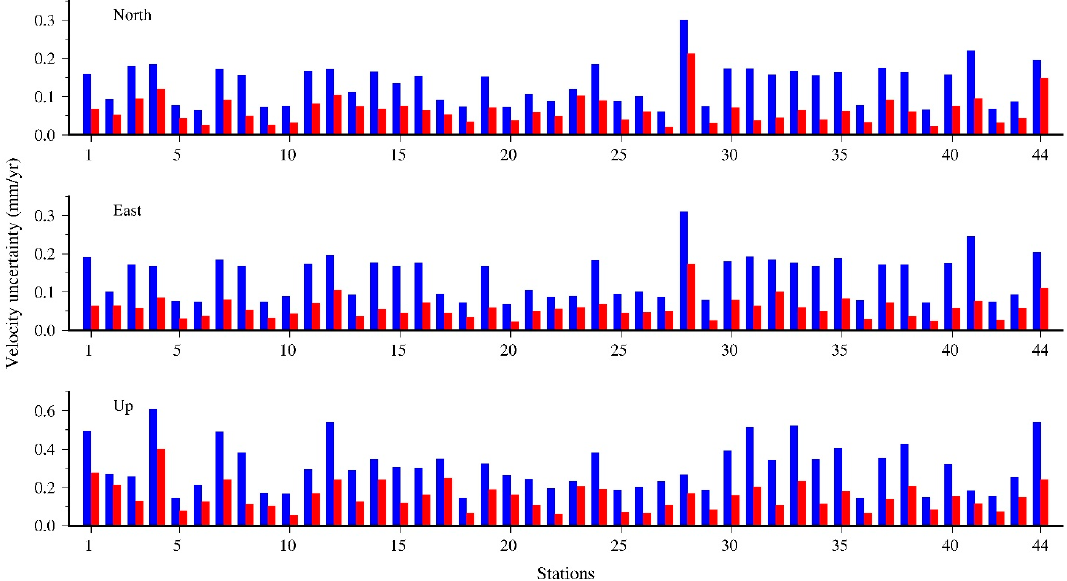
Figure 9. Velocity uncertainty of the 44 GNSS stations for the north, east, and up (NEU) components before (blue bars) and after (red bars) CME filtering with VBPCA.